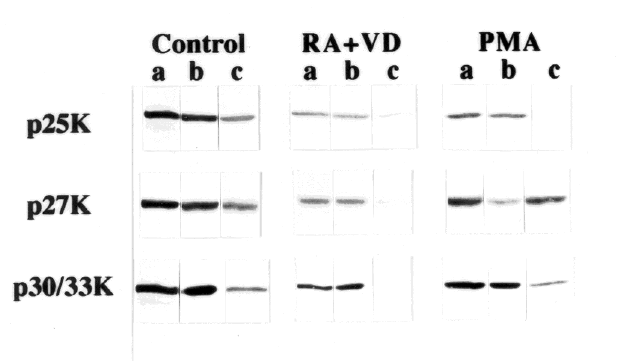
Fig. 7. Western blot detection of proteasomal proteins in whole cell extracts (lanes a), post-mitochondrial supernatant (lanes b) and nuclear pellet (lanes c) isolated from control and induced U937 cells. Cells were incubated 72 h with inducers and fractionated, the proteins separated by SDS-PAGE, blotted on NC and analyzed with the monoclonal antibodies. In this case, the gel was voluntarily overloaded to allow nucleus antigens to become apparent.